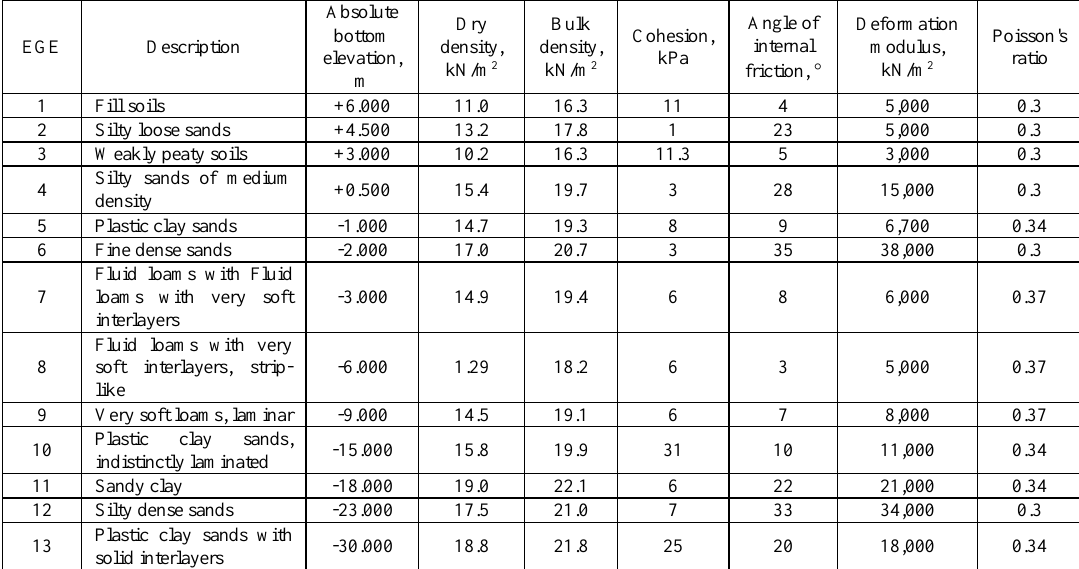
Table 2. Soil properties for variant